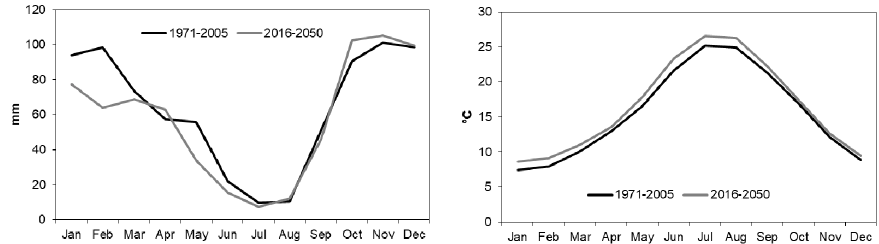
Figure 3. Changes in mean monthly precipitation (%) and temperature (°C) (2016–2050 vs. 1971–2005). Precipitation changes in terms of quantity and seasonal distribution significantly affect the surface water balance and the availability of water resources. The distributed water balance model cycle was used for a detailed study of each of the source nodes. For all the available source nodes,